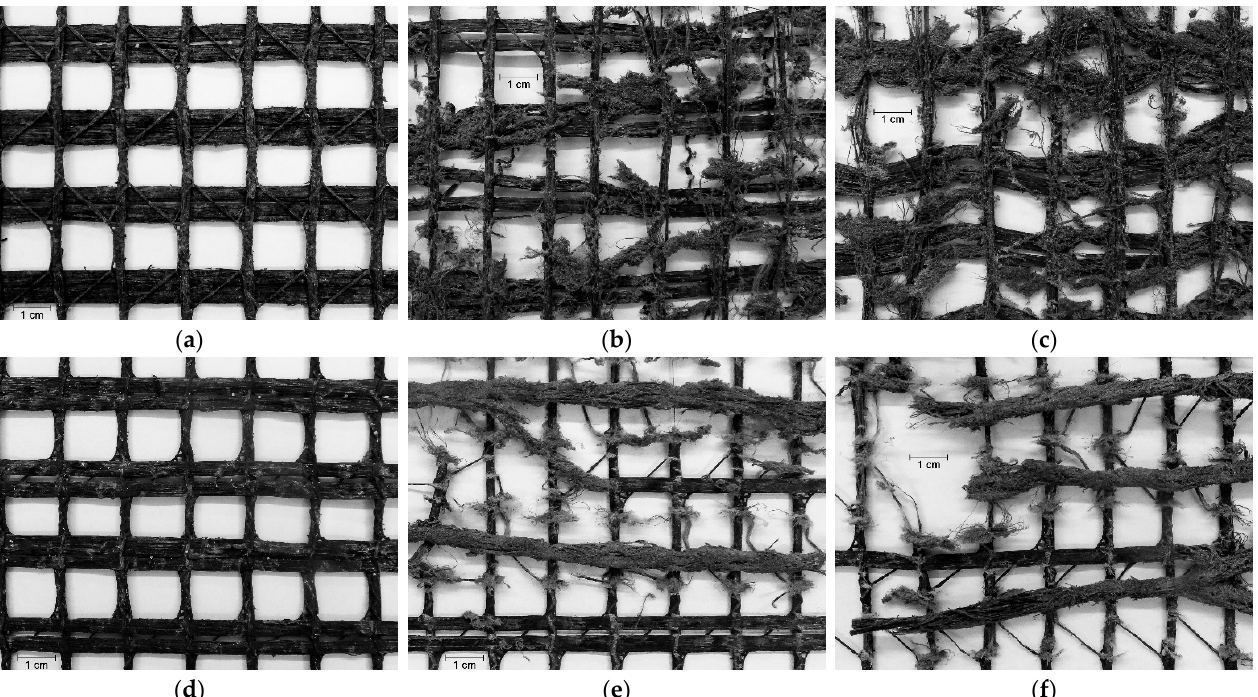
Figure 8. Visual inspection of WG-II after the degradation tests: ( a ) single exposure to MD tests (side A); ( b ) single exposure to abrasion tests (side A); ( c ) successive exposure to MD and abrasion tests (side A); ( d ) single exposure to MD tests (side B); ( e ) single exposure to abrasion tests (side B); ( f ) successive exposure to MD and abrasion tests (side B).